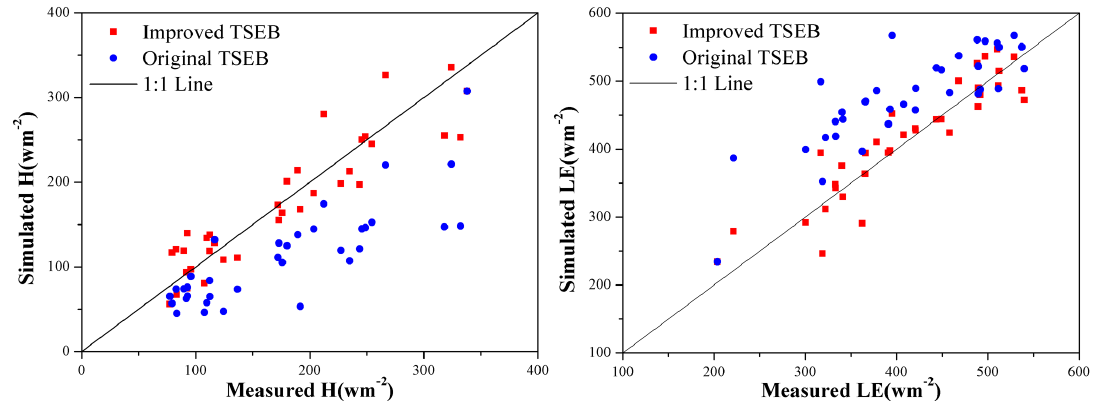
Figure 5. Scatterplots of the improved TSEB-derived energy fluxes versus EC tower-based measurements. Figure